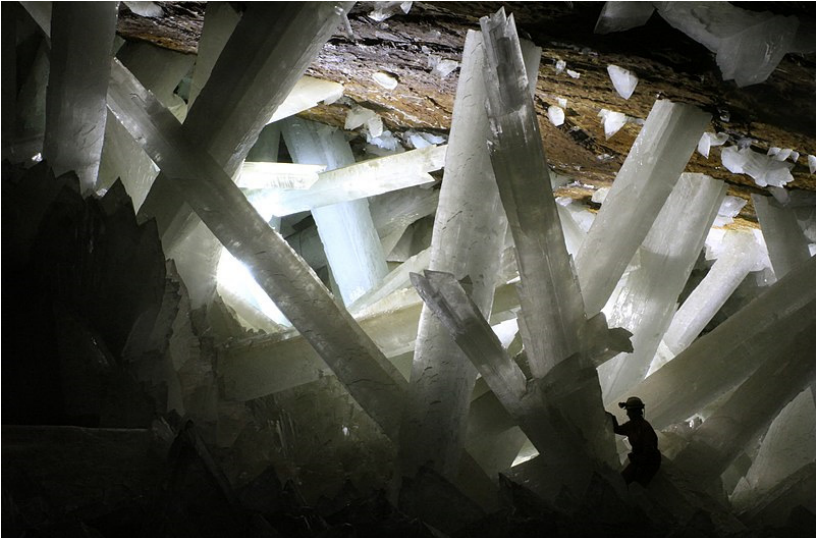
Figure 4. Gypsum crystals from the Naica mine (Person as scale reference). Photo taken by Van Driessche (2010) [12] and published under a Creative Commons License https://creativecommons.